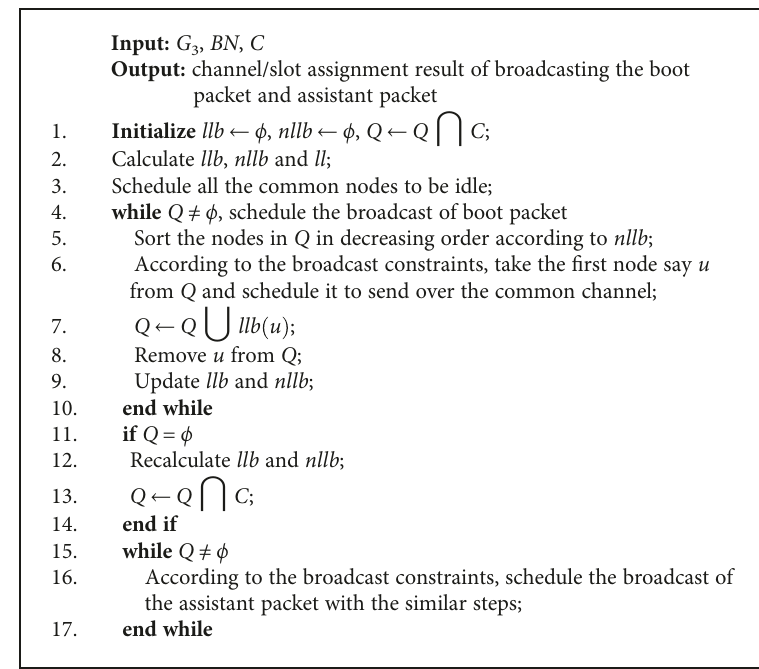
Algorithm 2: Channel/slot assignment for the preparation